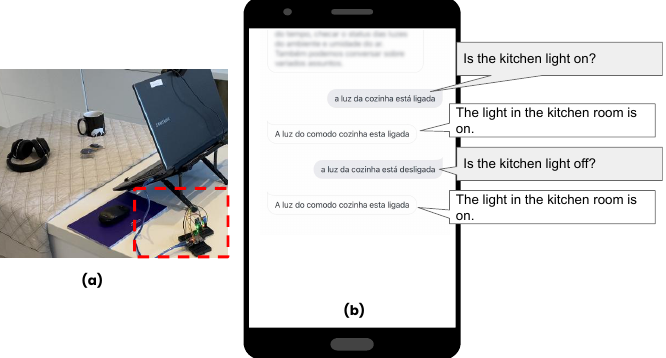
Figure 7. Homer execution ( a ) micro-controller board with sensors, and ( b ) identify whether the light is on or